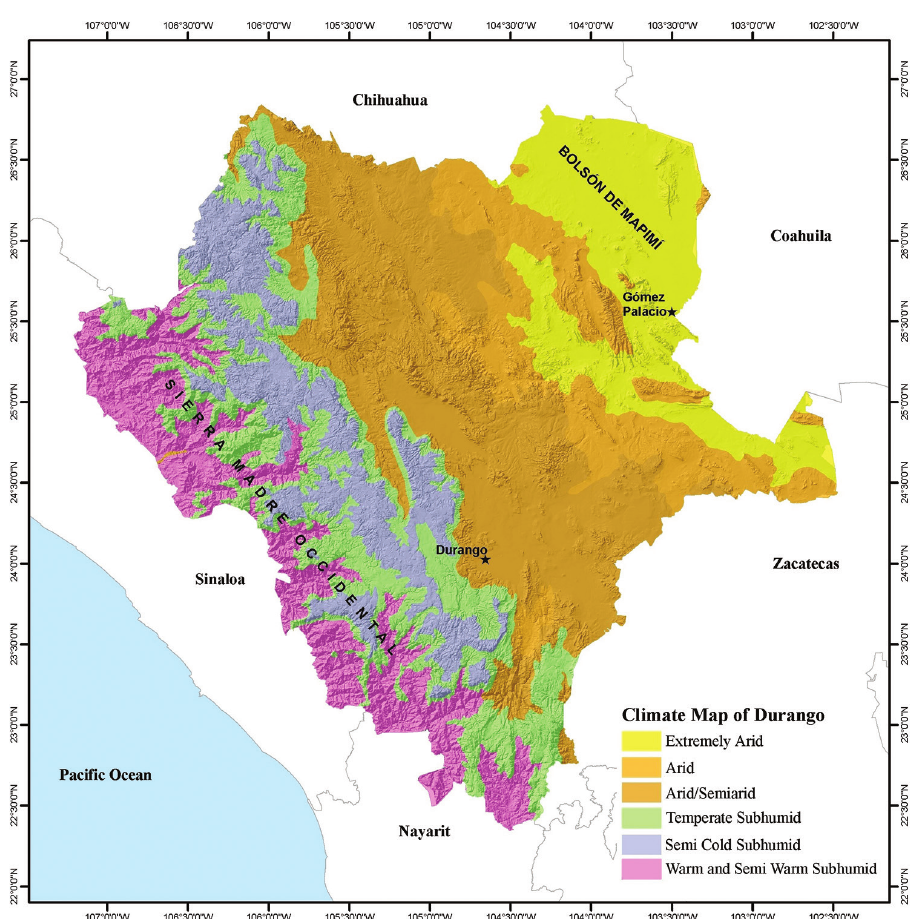
Figure 3. Climate map of the state of Durango, Mexico (modified from García – Comisión Nacional para el Conocimiento y Uso de la Biodiversidad